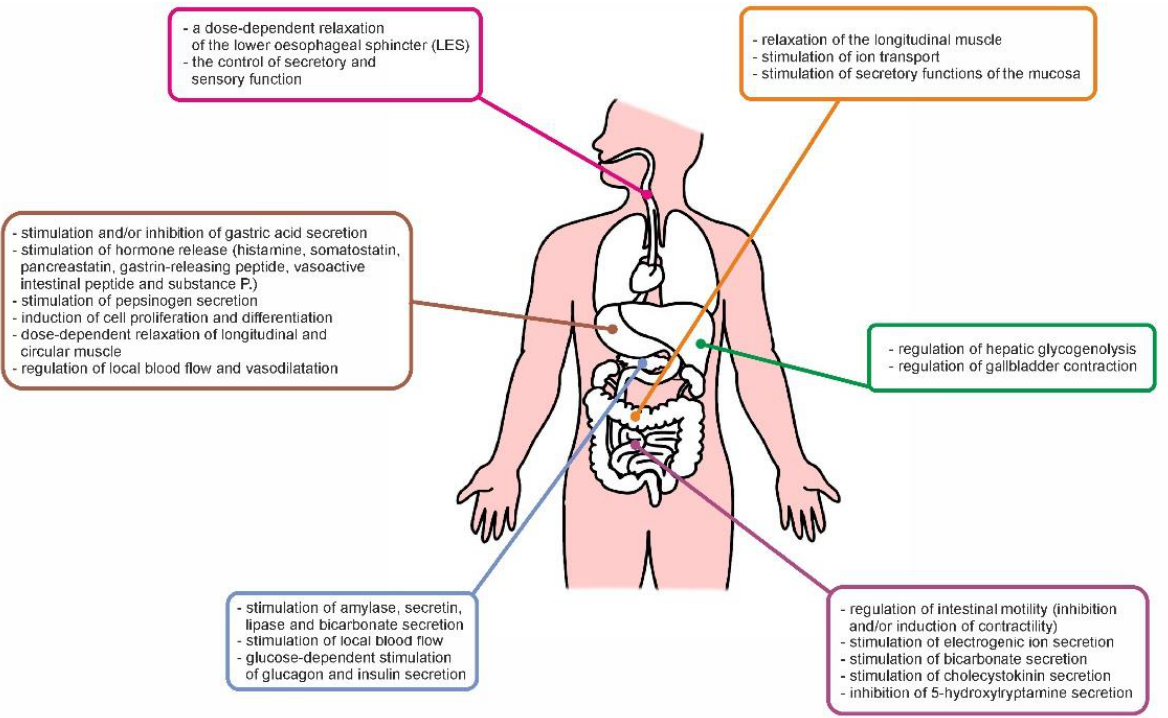
Figure 2. Summary of physiological effects of PACAP in the GI tract .